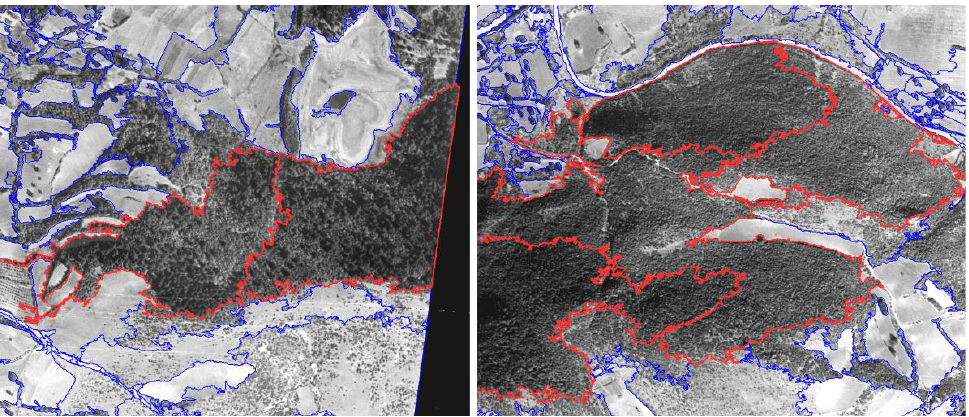
Figure 14. Segmented 1965 Ruen aerial photograph. Segments highlighted by red borders show the objects suitable for the “ tree cover ” class.